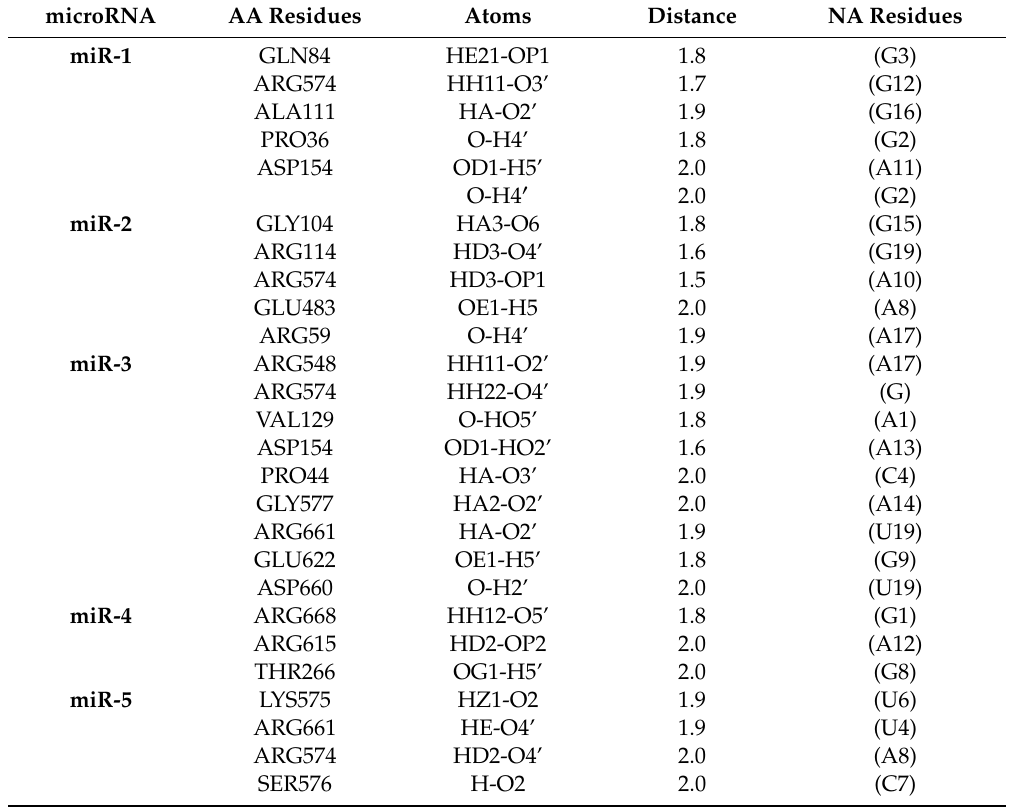
Table 8. Hydrogen bond interaction between the amino acid residues of the receptor and the candidate microRNAs within the distance of 2.0